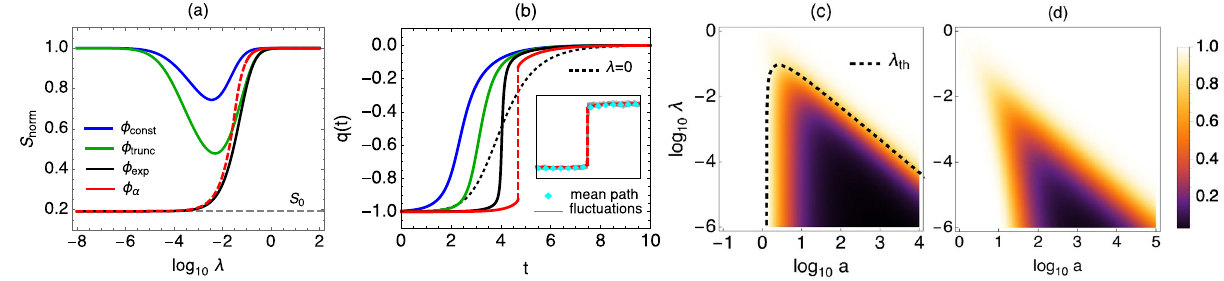
Figure 2. ( a ) The normalized action S norm = S min / S G for the different φ of Fig. 1 ( a = 10 , α = 0.8 , b = 1 / 2 , D = 1 ) and the potential V ( q ) = q 4 / 4 − q 2 / 2 . Noise amplitude distributions of type A ( φ const , φ trunc ) recover the Gaussian value S norm = 1 as (cid:31) → 0 . For type B and C amplitudes ( φ exp , φ α ), S norm decreases monotonically as (cid:31) → 0 and converges to a nontrivial limit S 0 , Eq. (15). The action for φ α corresponds to an escape path with a discontinuous jump when (cid:31) < (cid:31) th (red dashed line). ( b ) Instanton escape paths for the different φ showing a rapid motion from the initial minimum to the barrier; for φ α the instanton has a jump section. Colors, potential, and parameters as in ( a ) (apart from α = 1.2 and (cid:31) = 0.01 ). For non-Gaussian noise the time-reversal symmetry between excitation and relaxation paths is broken, seen here by the difference with the slower (cid:31) = 0 instanton of the Gaussian dynamics (dotted line). Inset: Mean path sampled numerically from the path weight for ǫ = 0.01 compared with theory for φ α , confirming the jump. ( c , d ) Colour maps of S norm for ( c ) φ α with α = 0.8 and ( d ) φ const . The dashed line is the phase boundary (cid:31) th ( a ) separating regions with smooth ( (cid:31) ≥ (cid:31) th ) and jump ( (cid:31) < (cid:31) th )